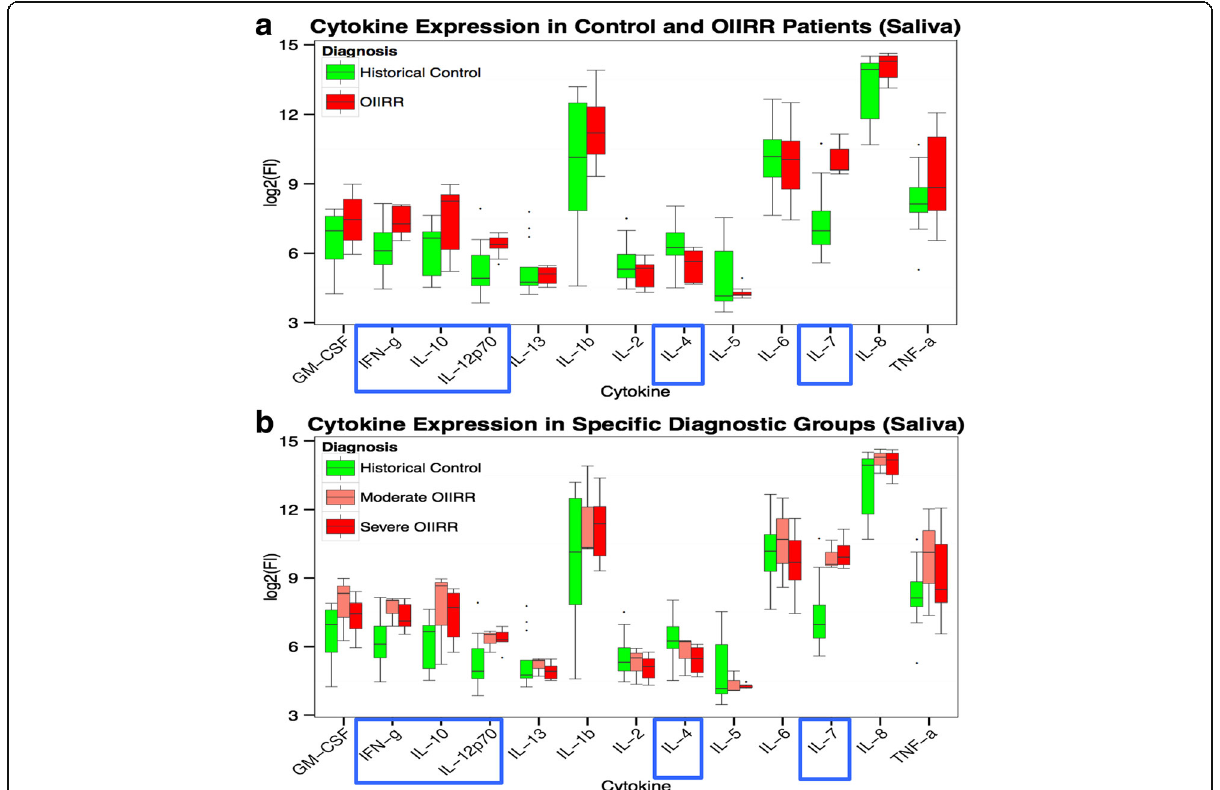
Fig. 3 Cytokine expressions in saliva samples according to ( a ) general diagnosis of OIIRR comprising of severe and moderate root resorption groups compared to CG and ( b ) specific diagnosis of moderate and severe OIIRR compared to CG. Cytokines that showed significant changes in their expression are identified by blue